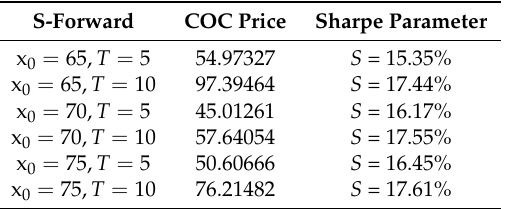
Table 9. Equivalent Sharpe parameters, CIR model.